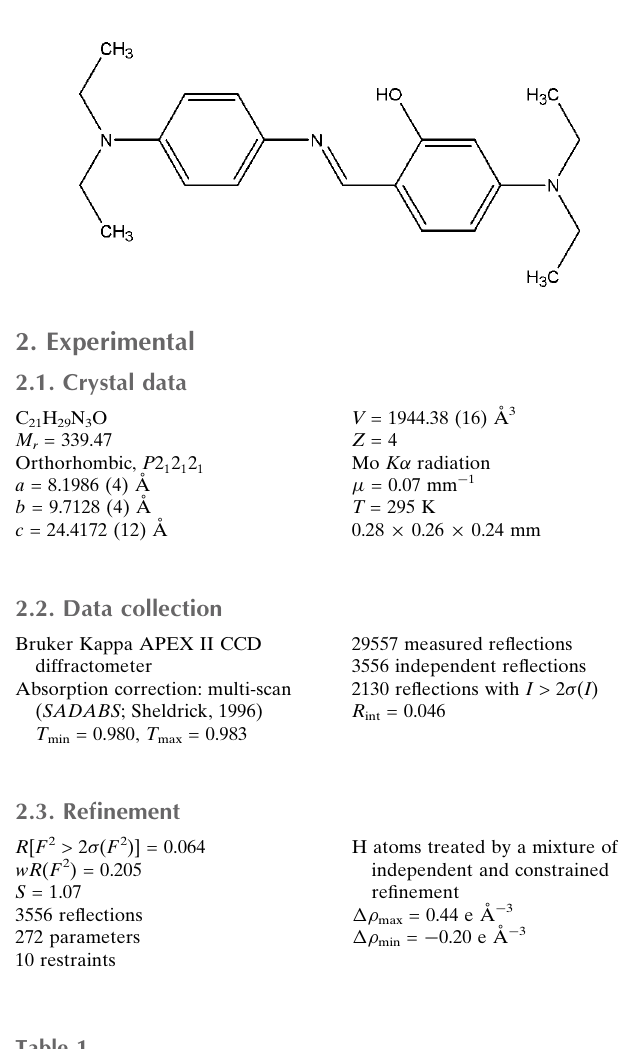
Hydrogen-bond geometry (A˚ , (cid:2)